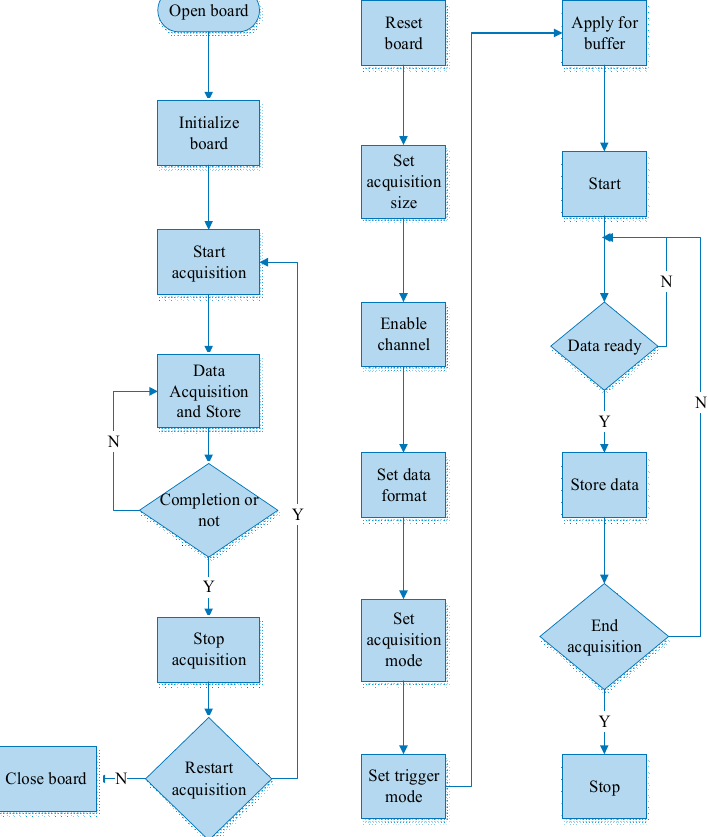
Figure 11. The designed data acquisition board. Table 3. Test parameters of acquisition.